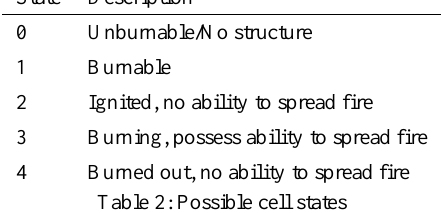
Table 2: Possible cell